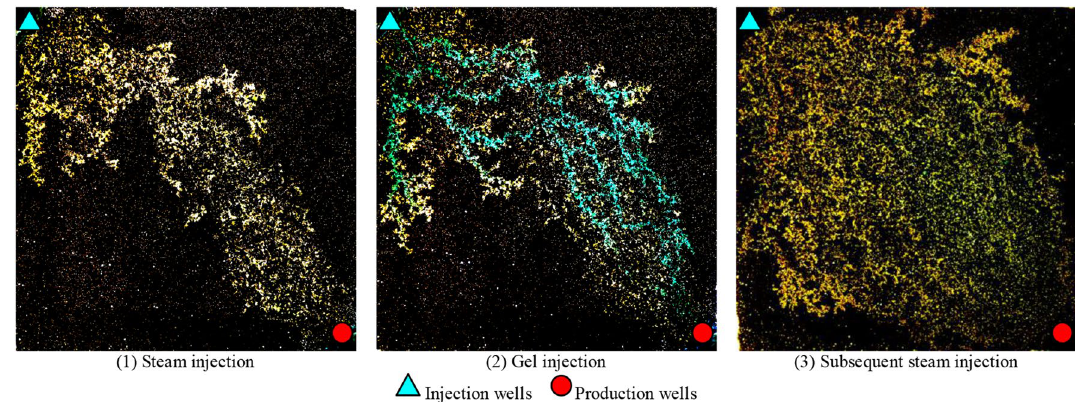
Fig. 6 The comparison diagram of areal swept zone of test